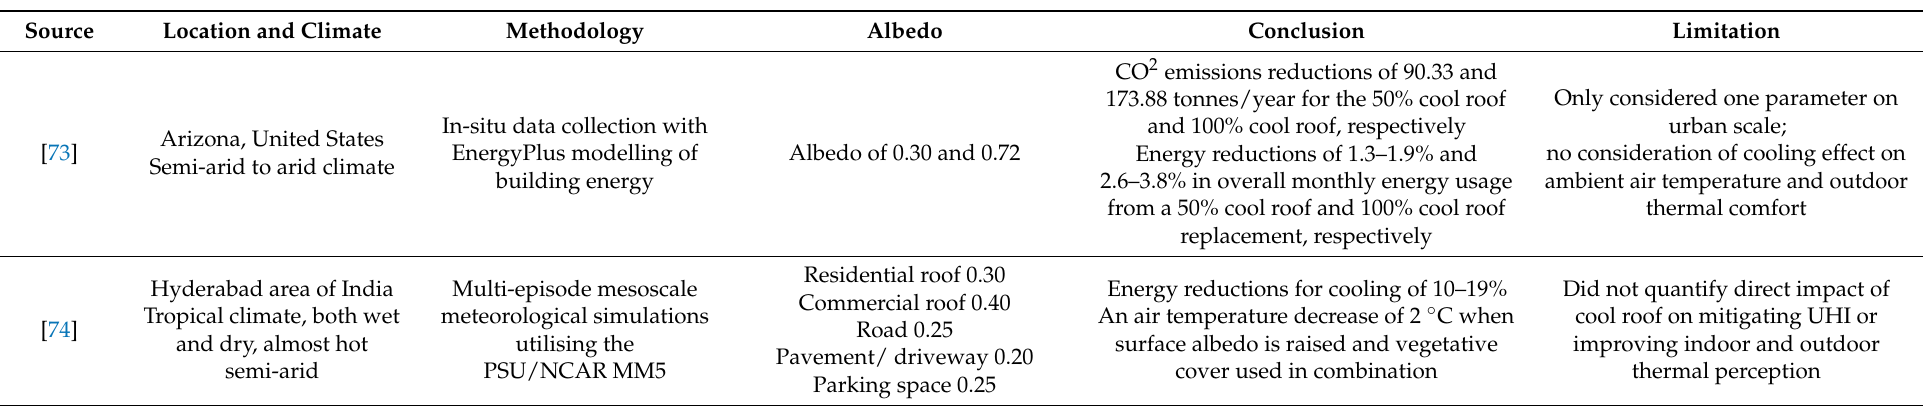
Table 3. List of studies examining the effect of cool roofs at the building and neighbourhood/city